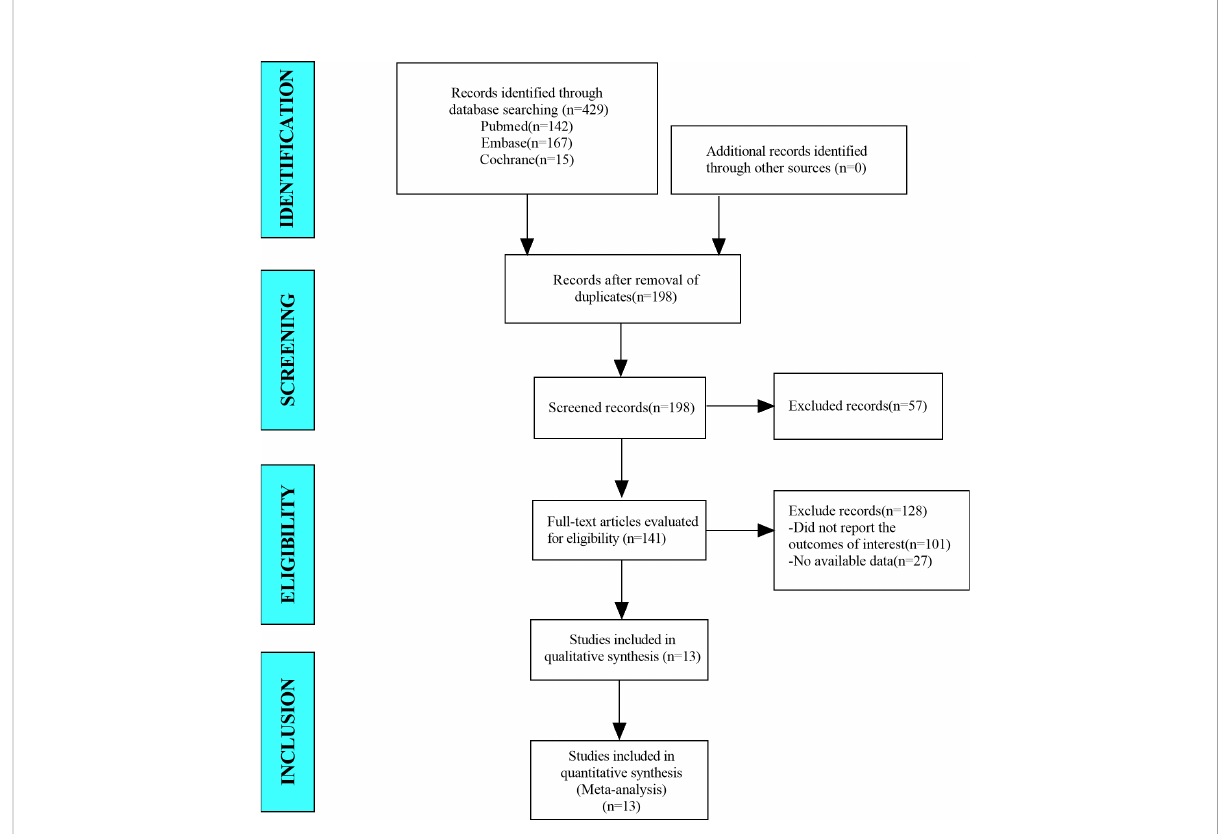
FIGURE 1 Flow diagram for selection of